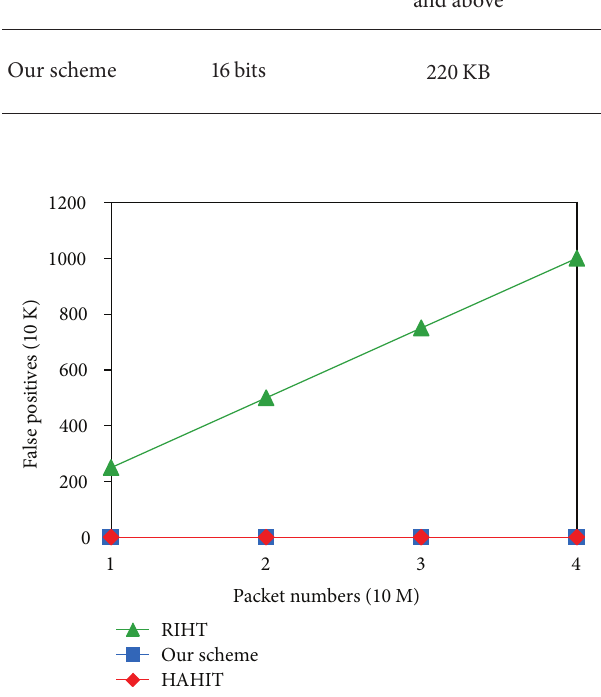
Figure 10: Comparison of false positives.